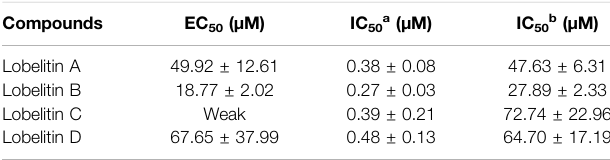
TABLE 1 | Pharmacological characteristics of active fl avonoid glycosides derived from Lobelia chinensis in HT-29 cells (Wang et al., 2019). Compounds